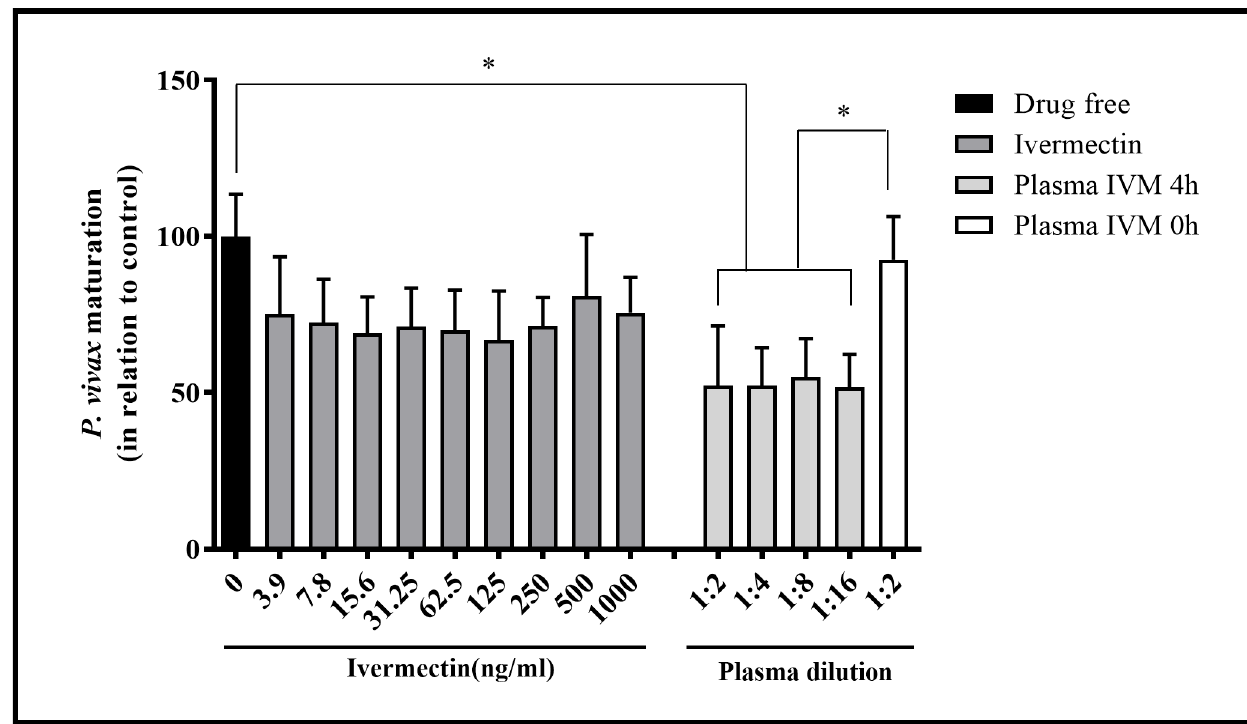
Fig 7. Metabolized ivermectin impairs asexual P . vivax maturation. Five P . vivax samples containing more than 80% of parasites on ring stage were evaluated. Nine different concentrations of pIVM were added to P . vivax culture. Moreover, plasma from healthy volunteers collected before (0 hours) and after 4 hours of IVM intake was added in 4 different serial dilutions (1:2) with complete medium. A drug free condition was used as the control. The number of schizonts in 200 asexual parasites was evaluated for each condition and the maturation in relation to control were determined. Asterisks ( (cid:3) ) represents significant differences (P < 0.05) in relation to control by Kruskal-Wallis